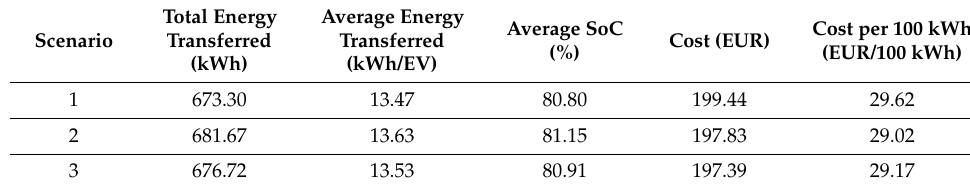
Table 1. Comparison of the costs of charging in each